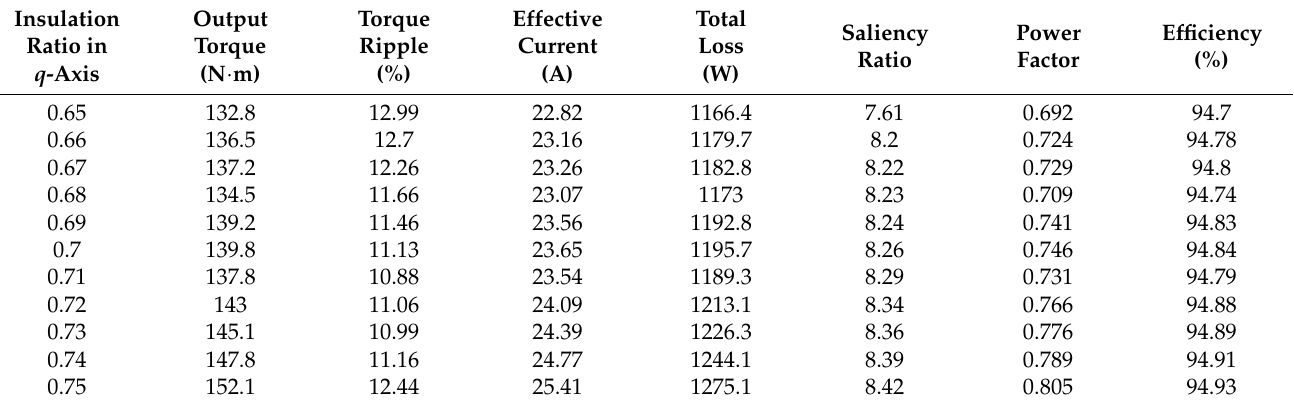
Table 5. Analyzes on q -axis insulation